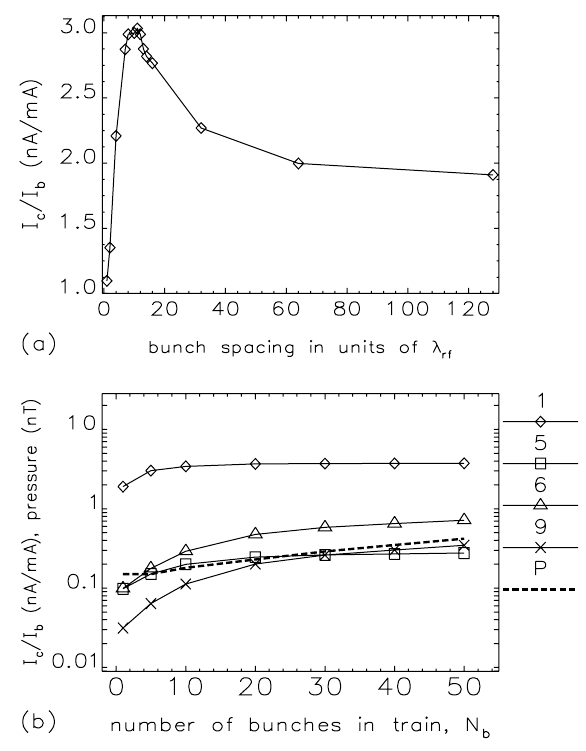
FIG. 13. (a) Detector 1 for ten bunches as a function of bunch spacing. (b) Growth and saturation of electron cloud over the , as a function of the train of electron bunches, spaced at 11 (cid:2) rf detector number. The local pressure P is also shown. In all cases, the bunch current is 2 mA. There is an additional surface conditioning of 100 Ah for these data, compared with Fig.